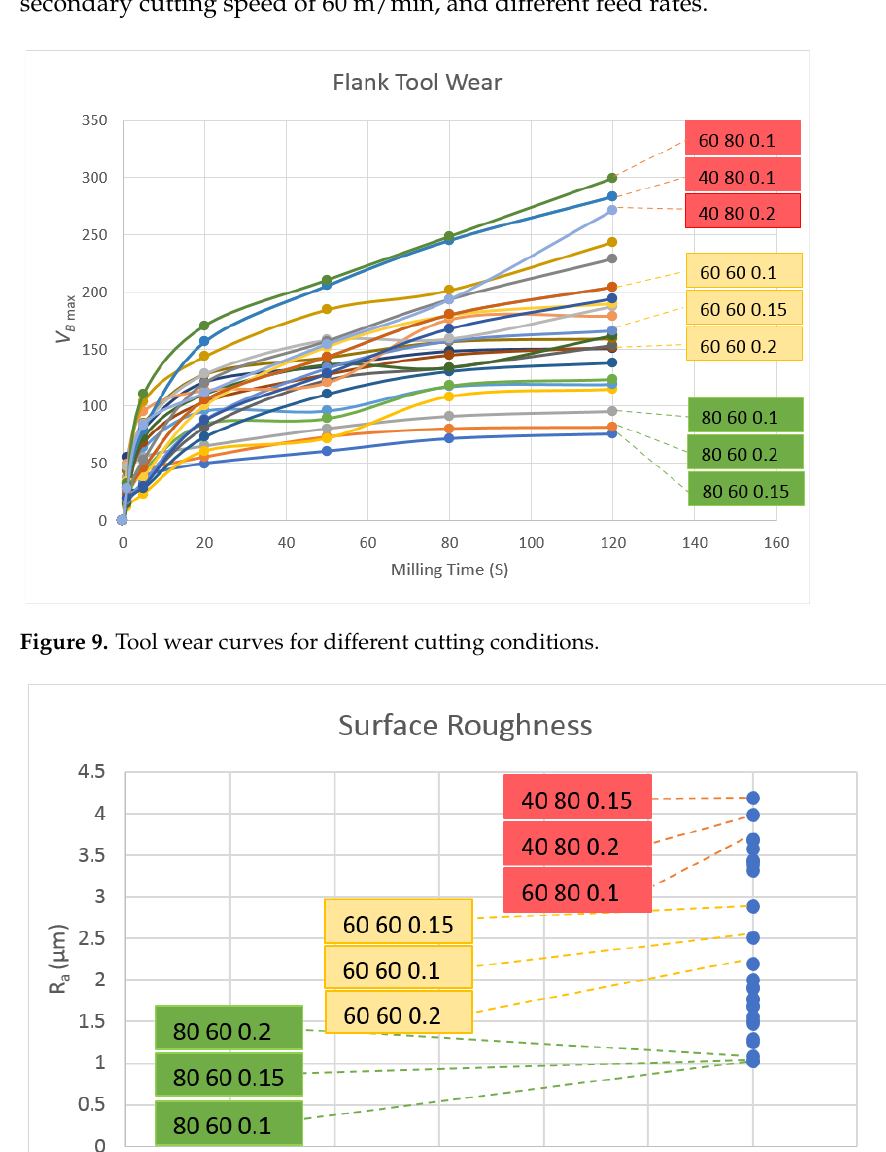
Figure 8. Probability plot of S/N, data points (blue dots) are relatively close to fitted normal distri- bution lines